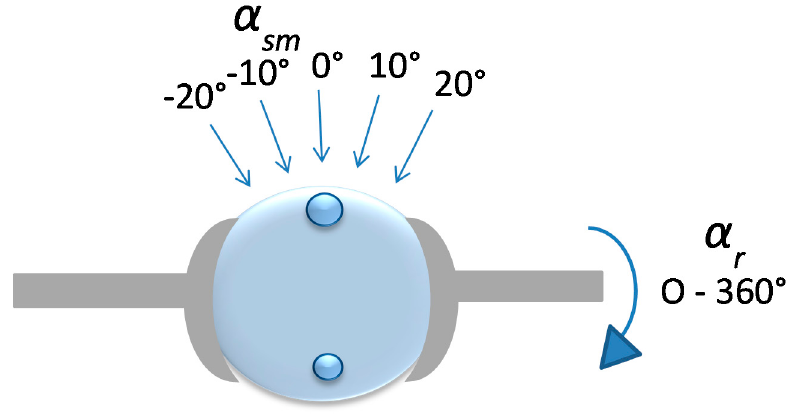
Figure 2. Illustration of a silicone sphere with embedded inclusions mounted in the rotatable sample holder. The movement of the sensor (not shown) for each MP was always kept perpendicular to the surface of the silicone. This was ensured by the rotation of the rotational stage by an angle α sm .